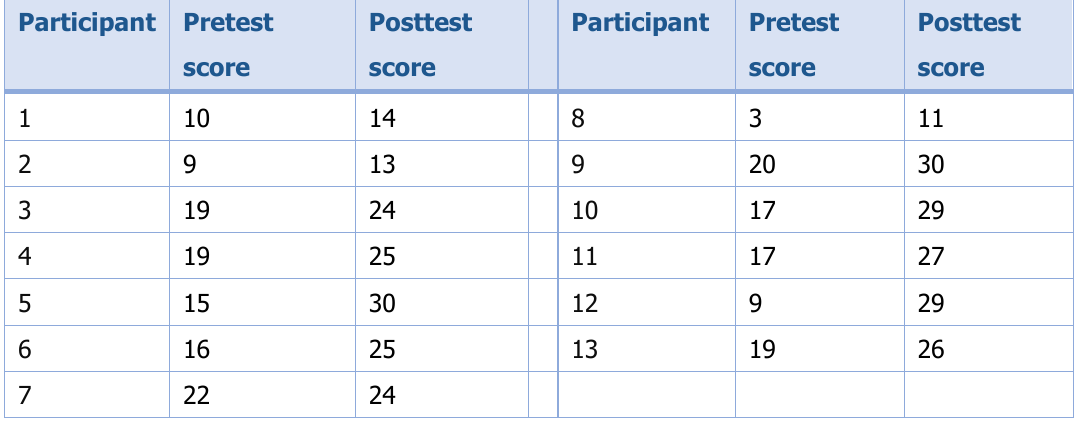
Table 5. Equine Assisted Learning Participant Scores for Pretest and Posttest for Equine Knowledge Assessments in At-Risk